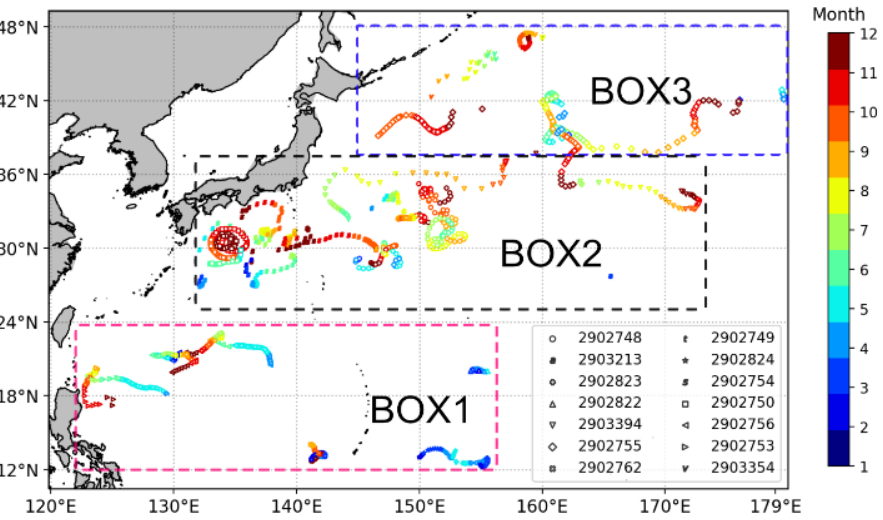
Figure 2. Locations and measuring months of 14 BGC-Argo profiles with a subsurface chlorophyll maximum (SCM) feature in the northwestern Pacific Ocean.